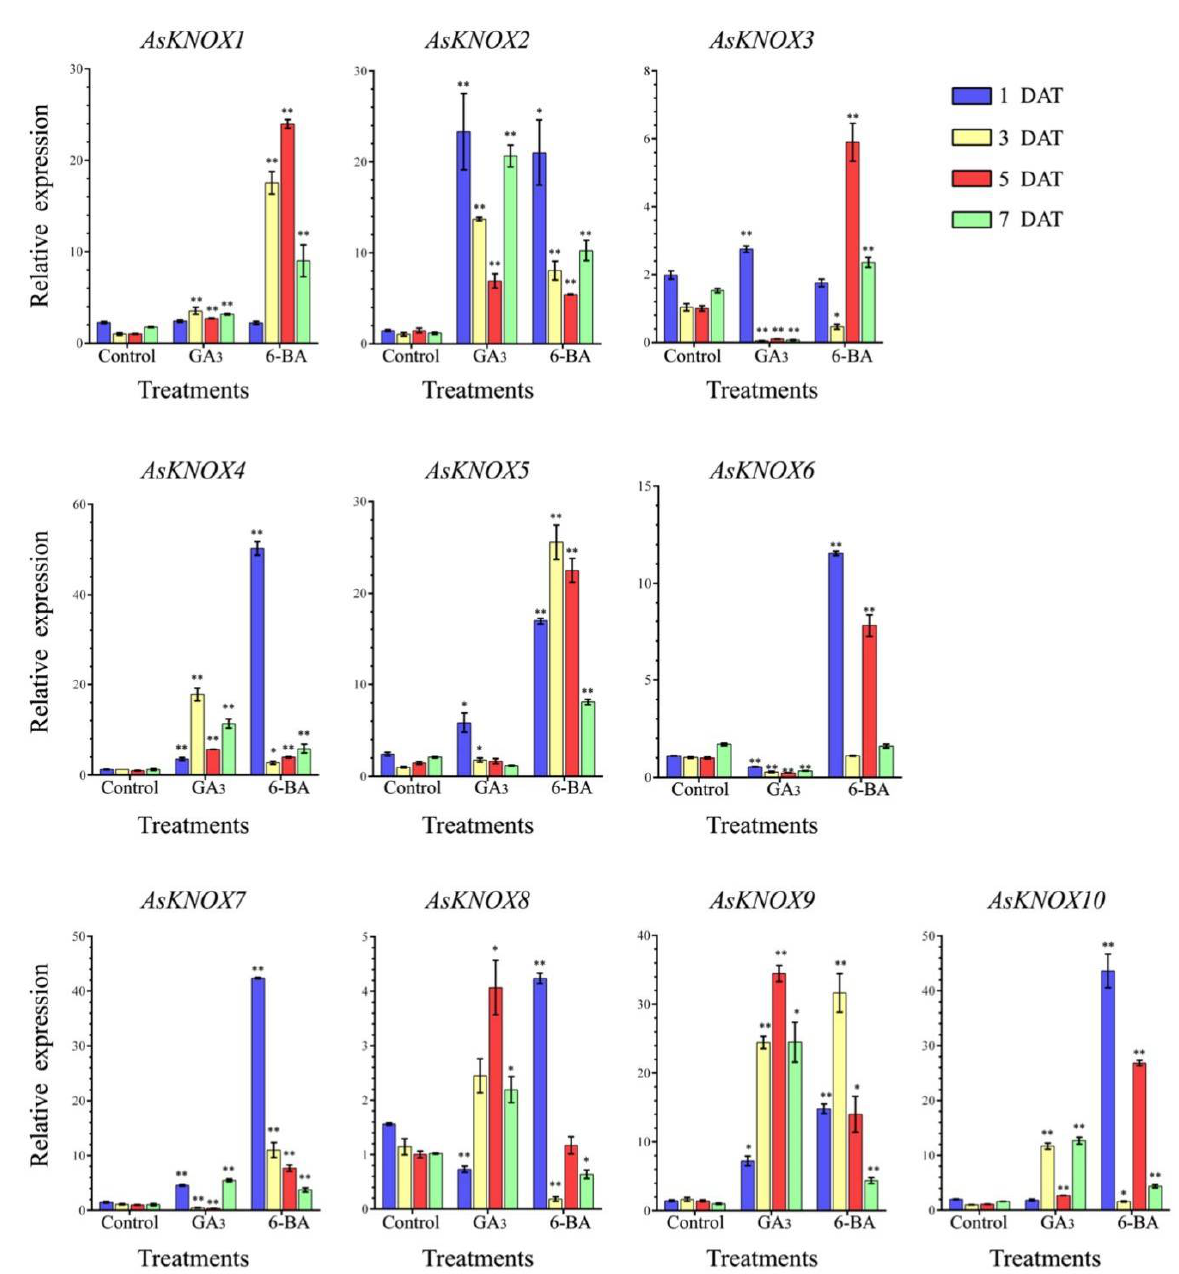
Figure 7. Expression analysis of the AsKNOX genes under exogenous GA 3 and 6-BA treatments. Student’s t-test was used to determine significant differences at the same period between control group and treatment group. Control means the control without any treatment, GA 3 means treated with exogenous GA 3 solution, 6-BA means treated with exogenous 6-BA solution. Significance level: * p < 0.05. ** p < 0.01.